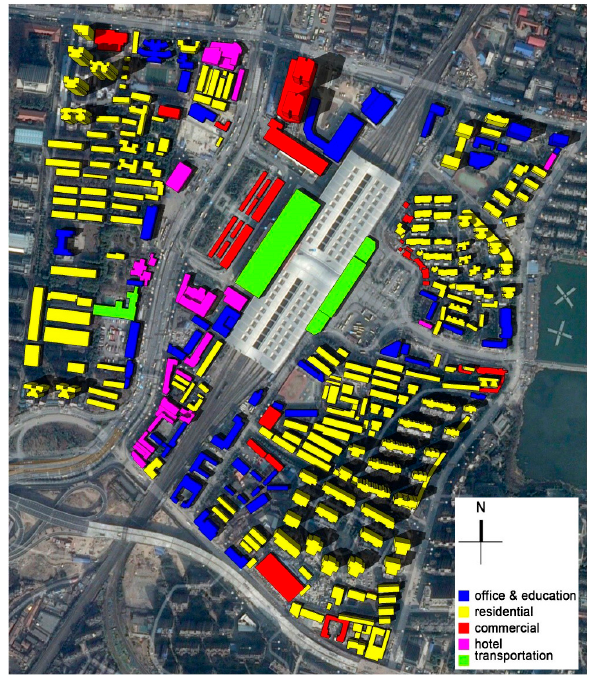
Figure 8. Modelling building stock with five building types in the study area.